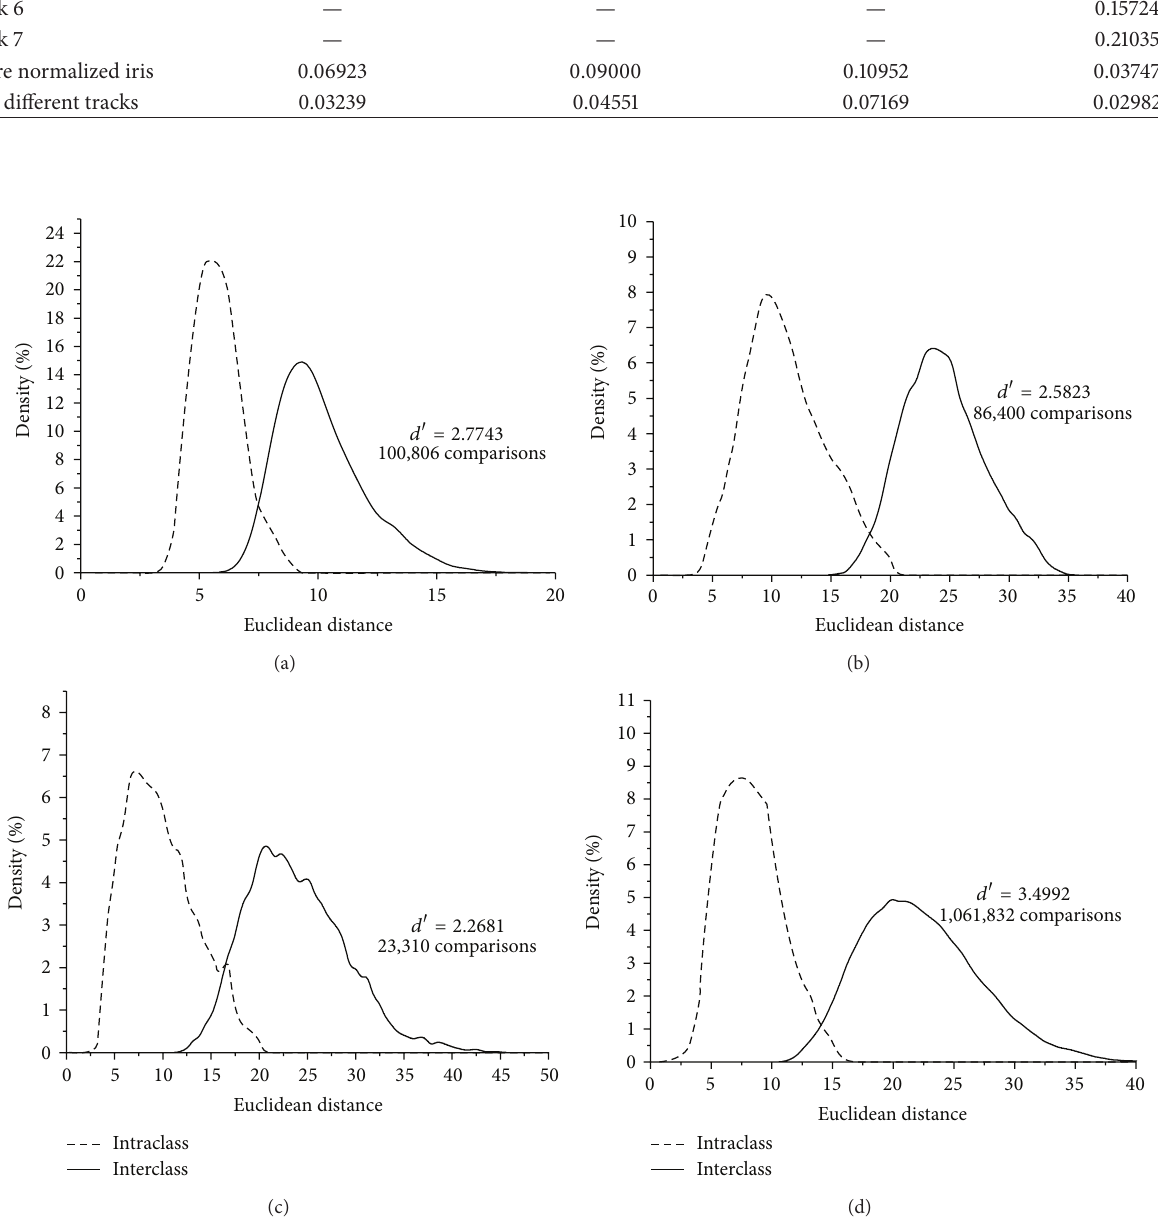
Figure 11: Distance distributions of the intra-class and inter-class patterns for the four iris image databases with fusion. (a) CAISA-V1, (b) CASIA-V3 Interval, (c) MMU-V1 and (d)